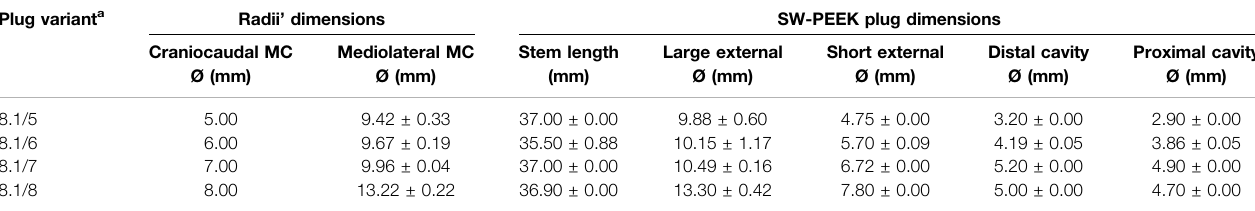
TABLE 3 | SolidWorks-designed radii plug variants dimensions and radii medullary cavity (MC) diameters where variants were inserted.